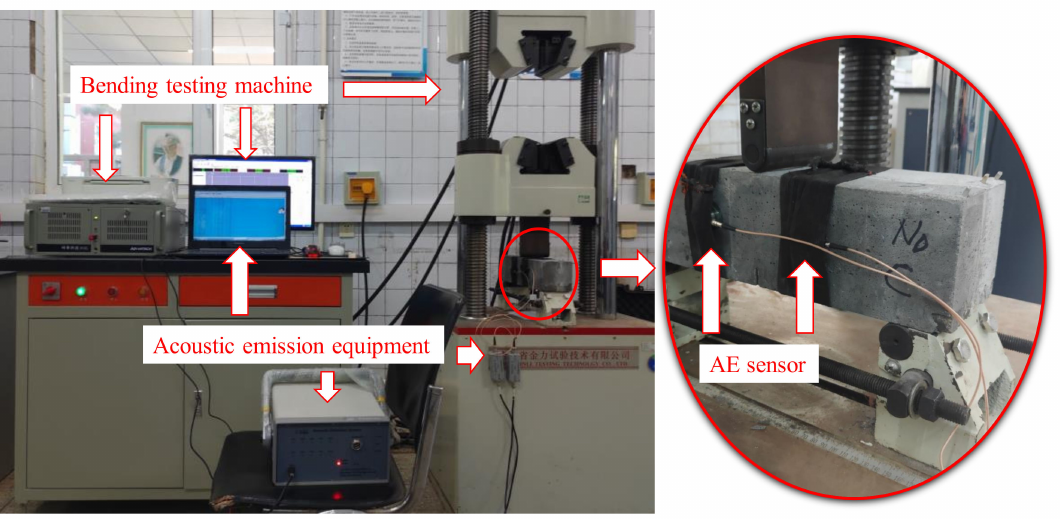
Figure 8. Experimental setups for the bending test and AE test.